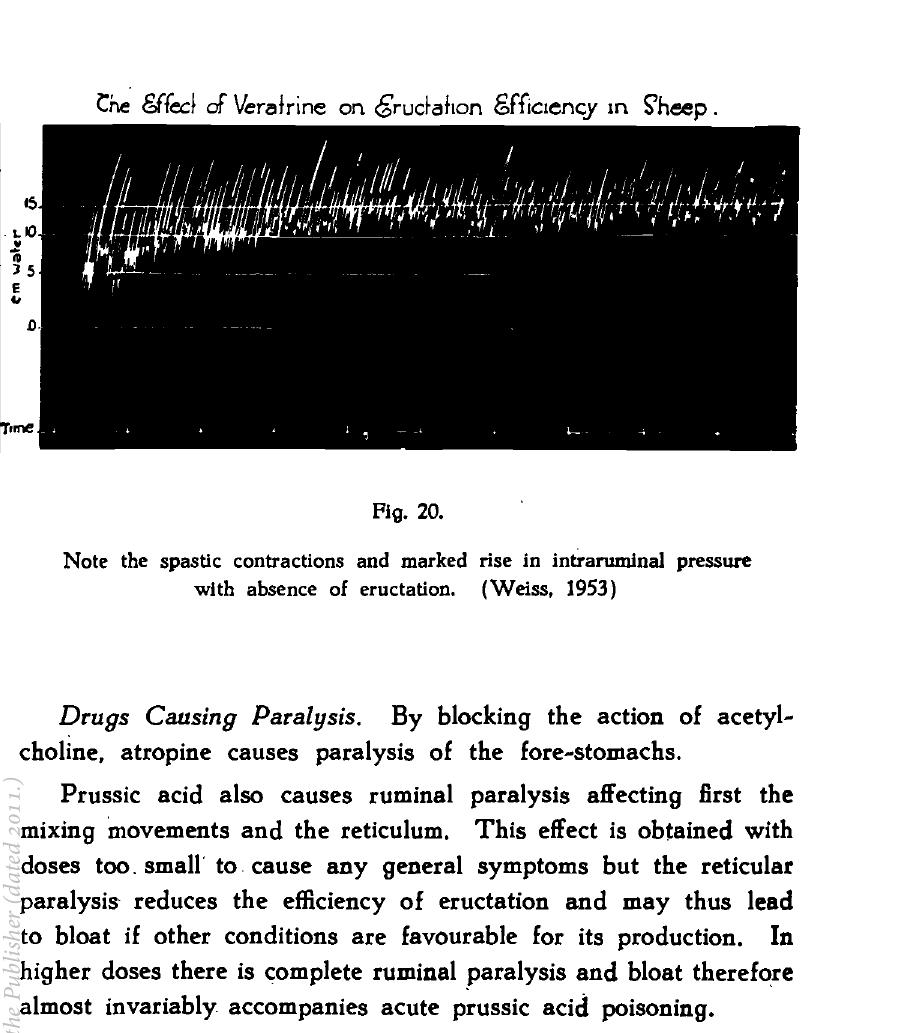
Note the spastic contractions and marked rise in intrarumlnal pressure with absence of eructation. (Weiss.